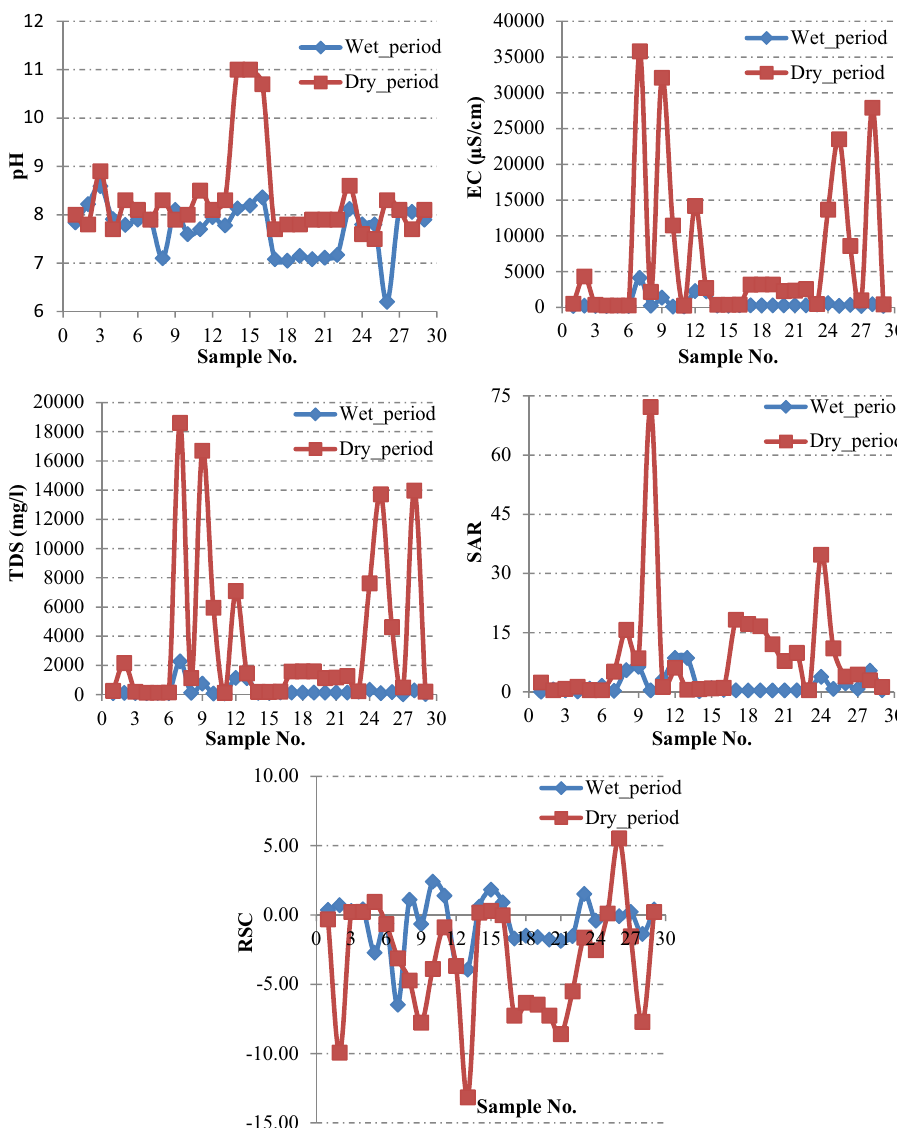
Fig. 2 Graphical representation of the surface water quality in the coastal area in